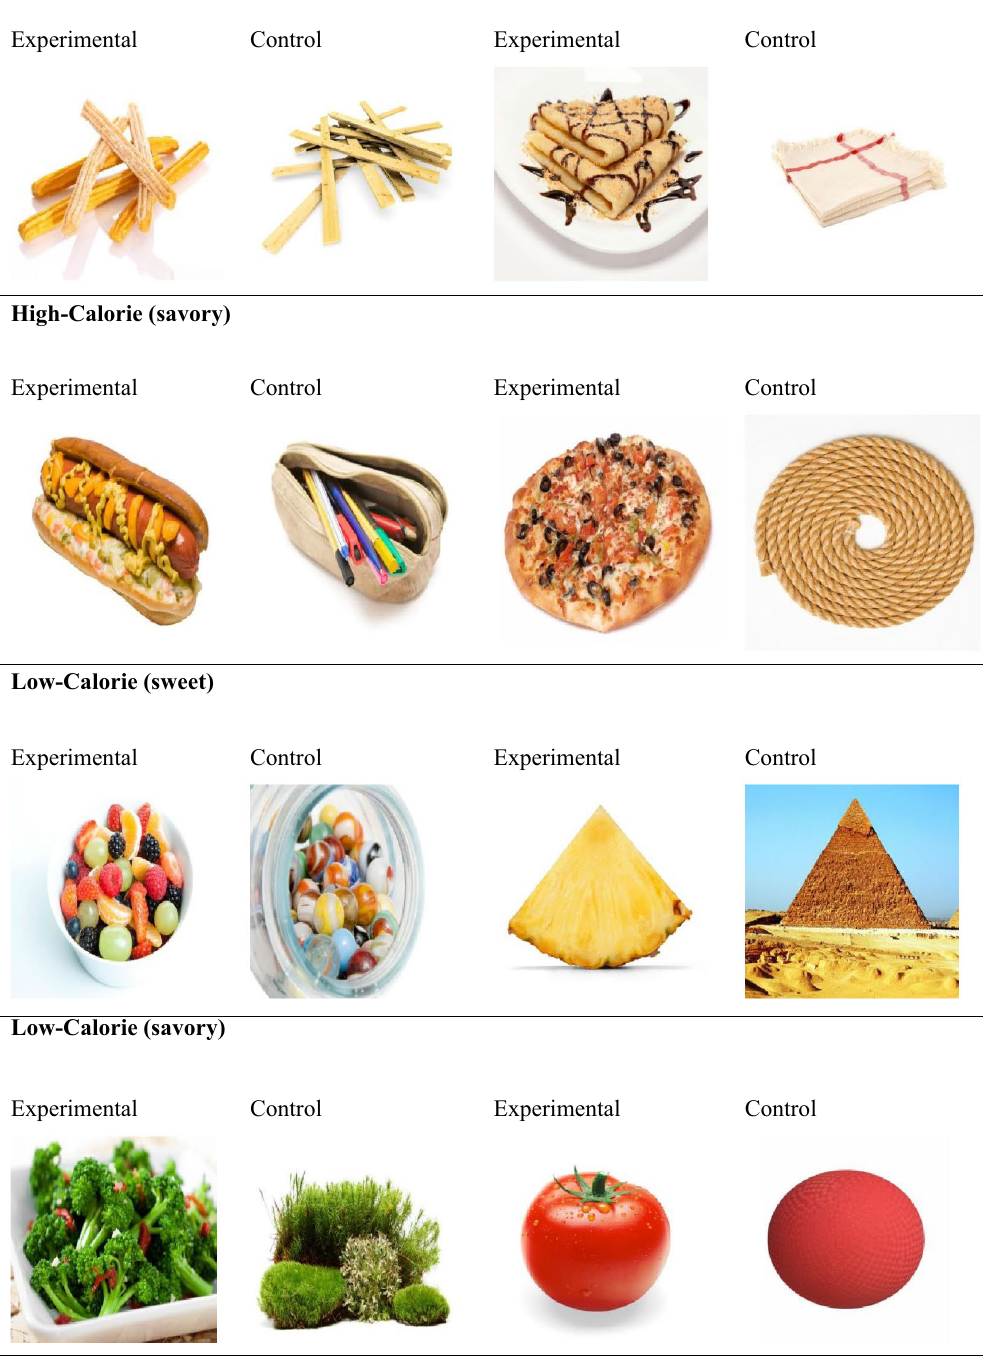
Figure 1. This Figure was designed by the authors of the present article and exposes the experimental pictures used in this study, paired with their control picture, for both high- and low-calorie foods associated with savory and sweet foods. The pictures, free of right, were taken from the FoodCal database 43